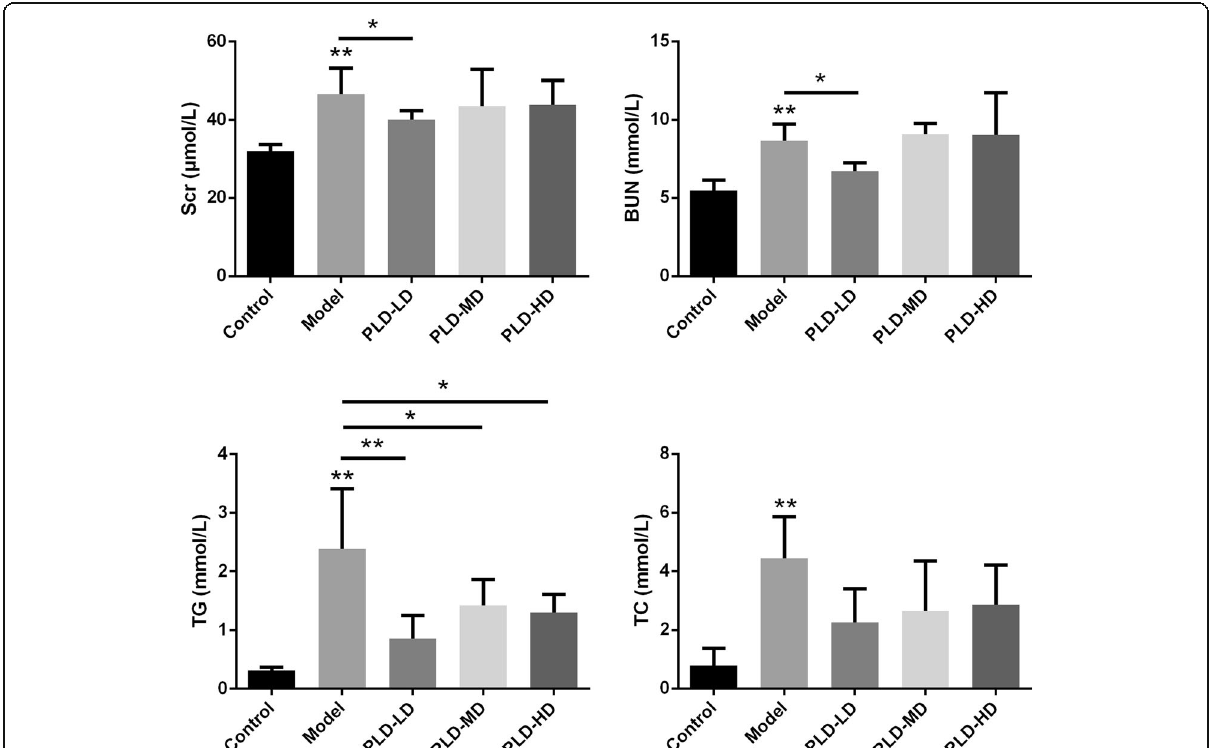
Fig. 2 Evaluation of renal function. The levels of Scr ( μ mol/L), BUN (mmol/L), TG (mmol/L), and TC (mmol/L) in serum from different groups of rats were determined by a chemical analszer (HITACHI 7180). Data ( n = 6) are presented as the mean ± SD. * p < 0.05; ** p <